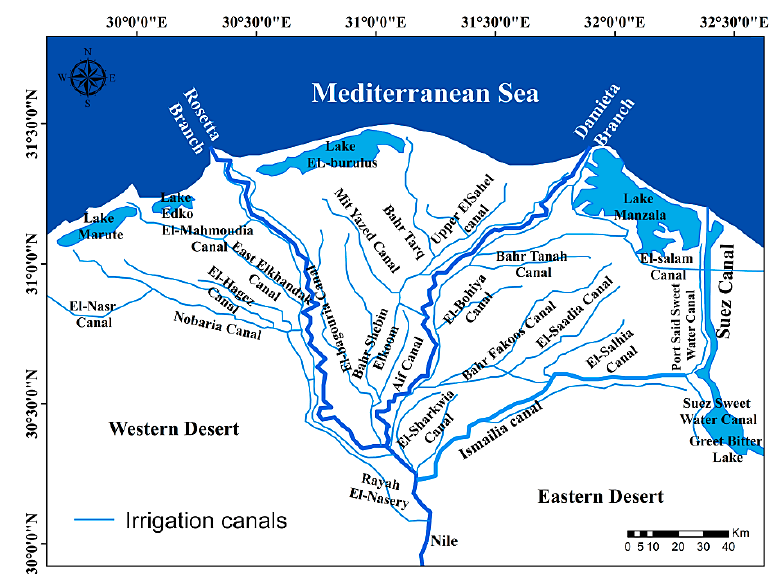
Figure 1. Irrigation canal networks in the Nile Delta [37].